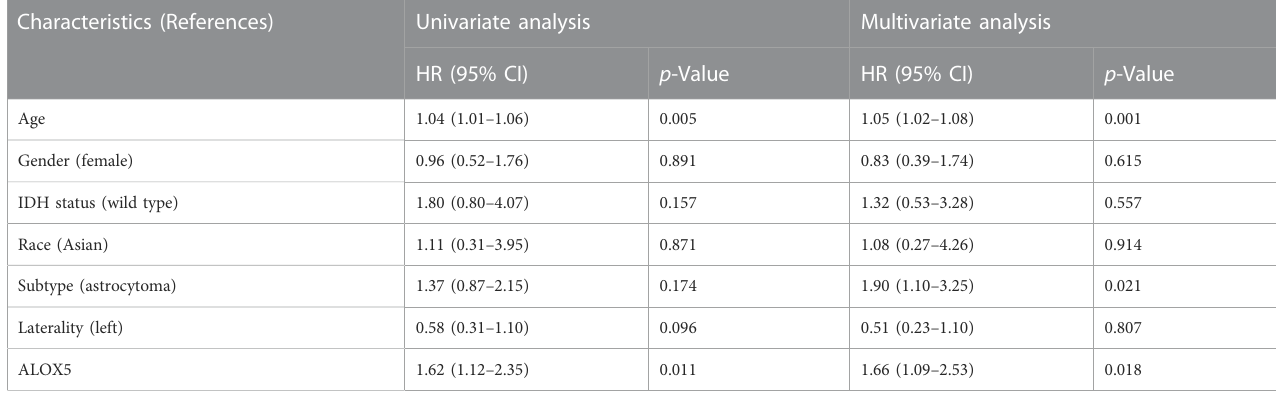
TABLE 3 Cox regression analysis of the association of ALOX5 and clinical variables with OS in the TCGA-LGG dataset. Characteristics